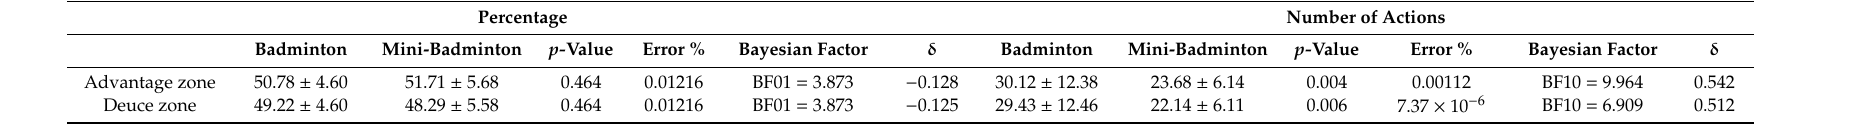
Table 2. Bayesian analysis of usage percentage and stock count technical and tactical according to service area.